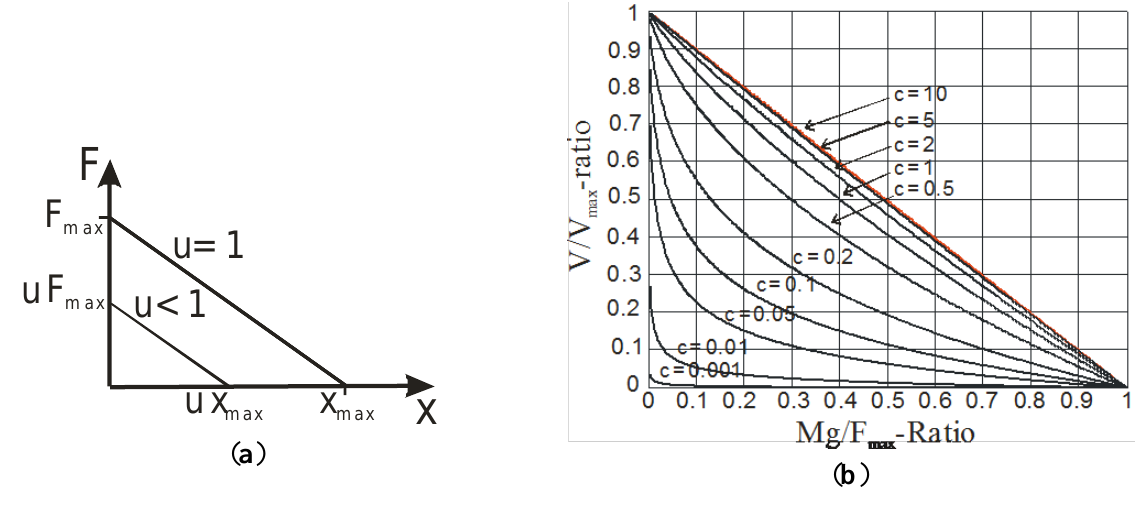
Figure 4. Linear artificial muscle characteristics; ( a ) force-position characteristic; and ( b ) force-velocity characteristic defined as a pseudo-Hill curve (for u = 1)—see